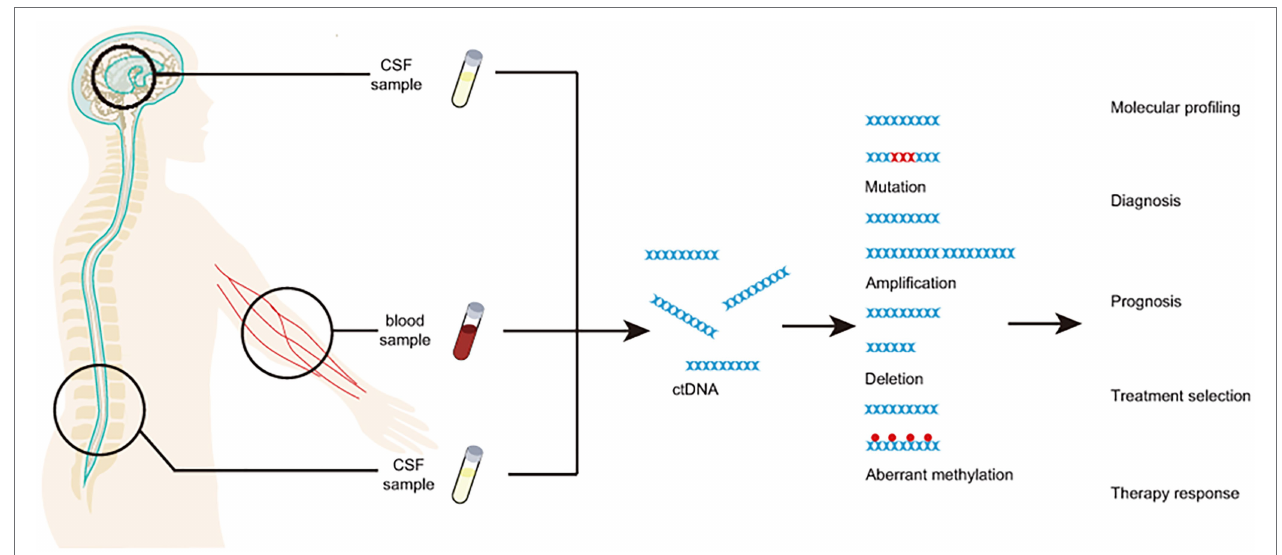
FIGURE 1 | CfDNA from blood and/or CSF as a minimally invasive analyte for liquid biopsy of brain